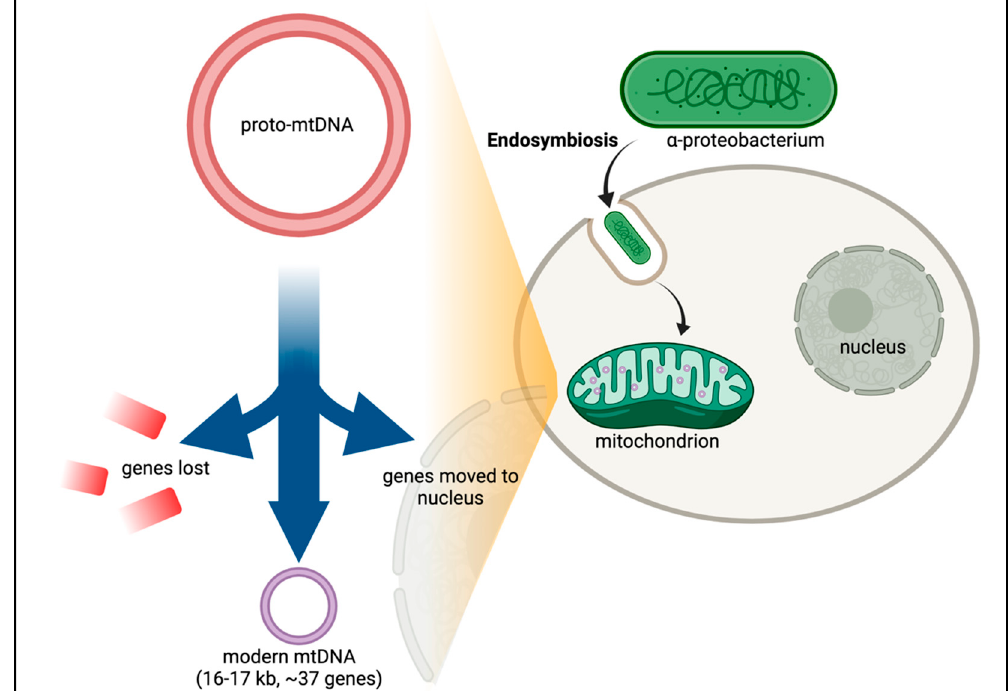
Figure 2. Endosymbiotic Theory and CoRR hypothesis. While the exact timing and emergency of eukaryotes is still unclear, recurrent gene transfer evidence supports the hypothesis that the original precursor to eukaryotic cells was a prokaryotic microbe that ingested an aerobic bacterium [20]. Following a period of evolution, the proto-mitochondrion would then have lost the genes which permitted adaptation of the free-living bacterium to environmental changes. Essential genes were also transferred from the bacterium into the nucleus. This gene transfer led to modern mtDNA in which only genes with core roles in the electron transport chain were retained in the mtDNA.